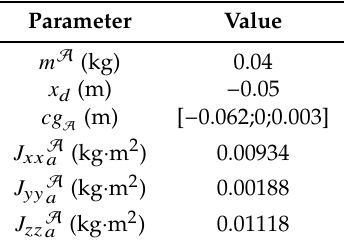
Table 4. Disturbance mass